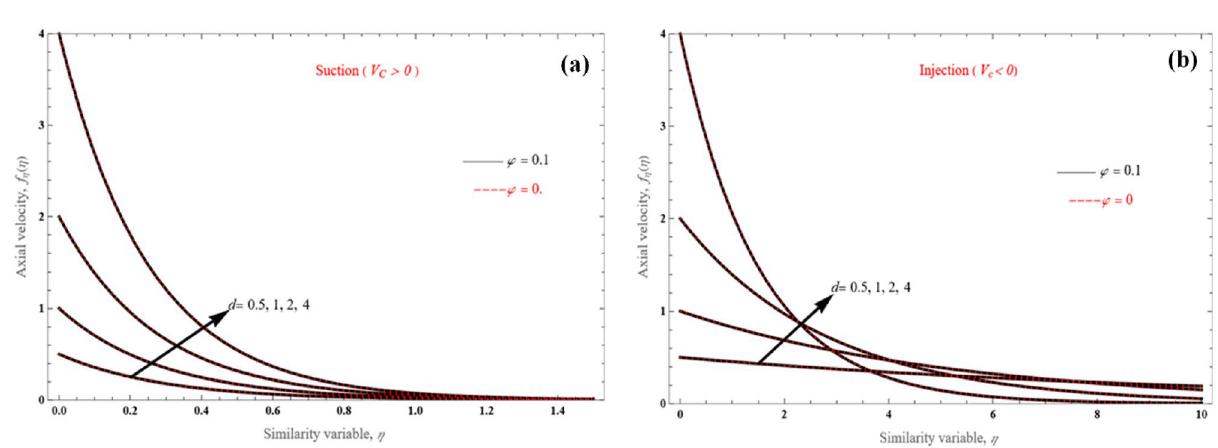
Figure 2. The tangential velocity patterns for the ( a ) upper branch and ( b ) lower branch solution, for various d values.